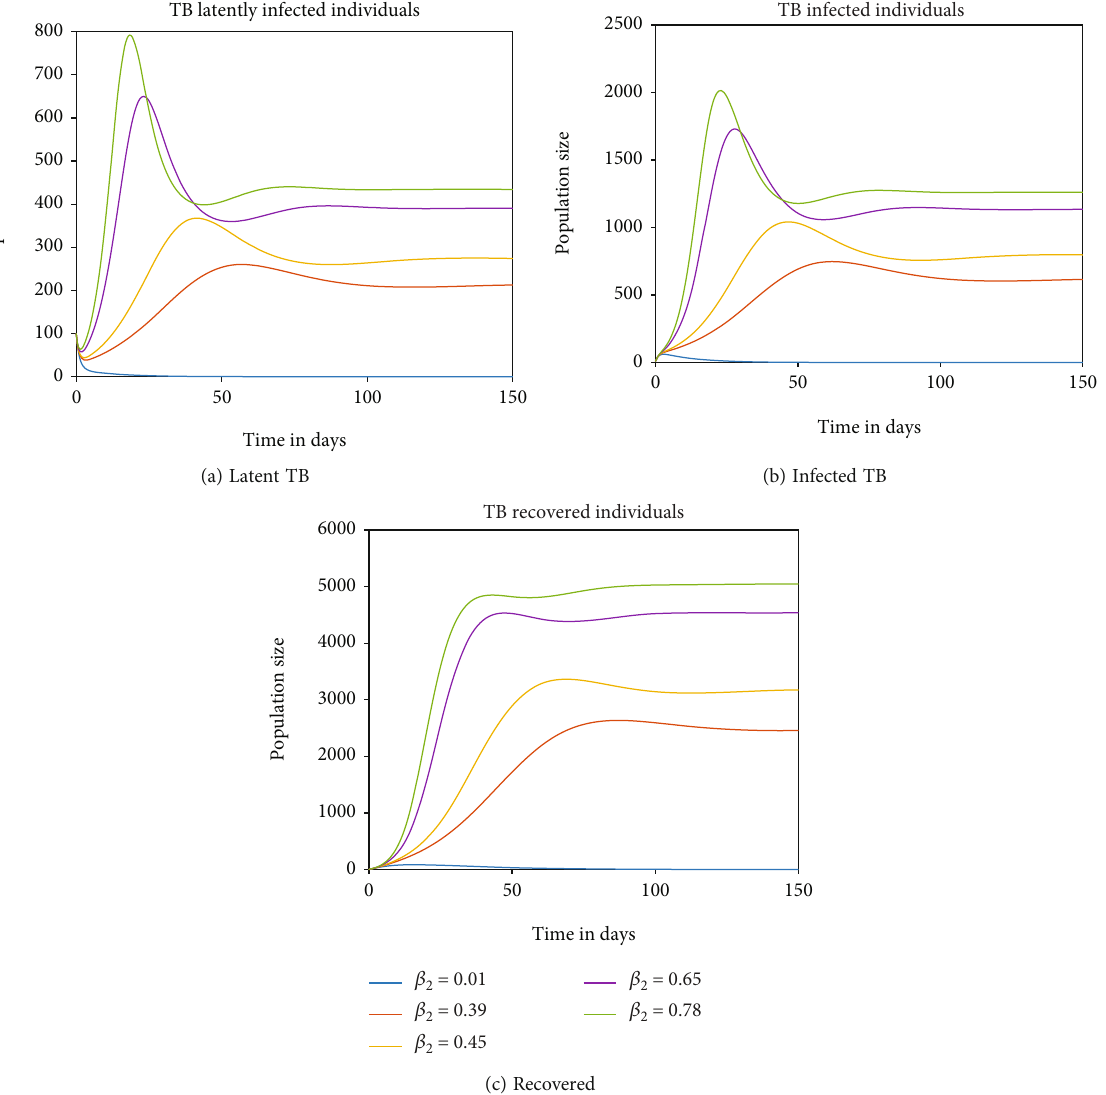
1 ) for the TB model, with other parameter values described in Figure 8.